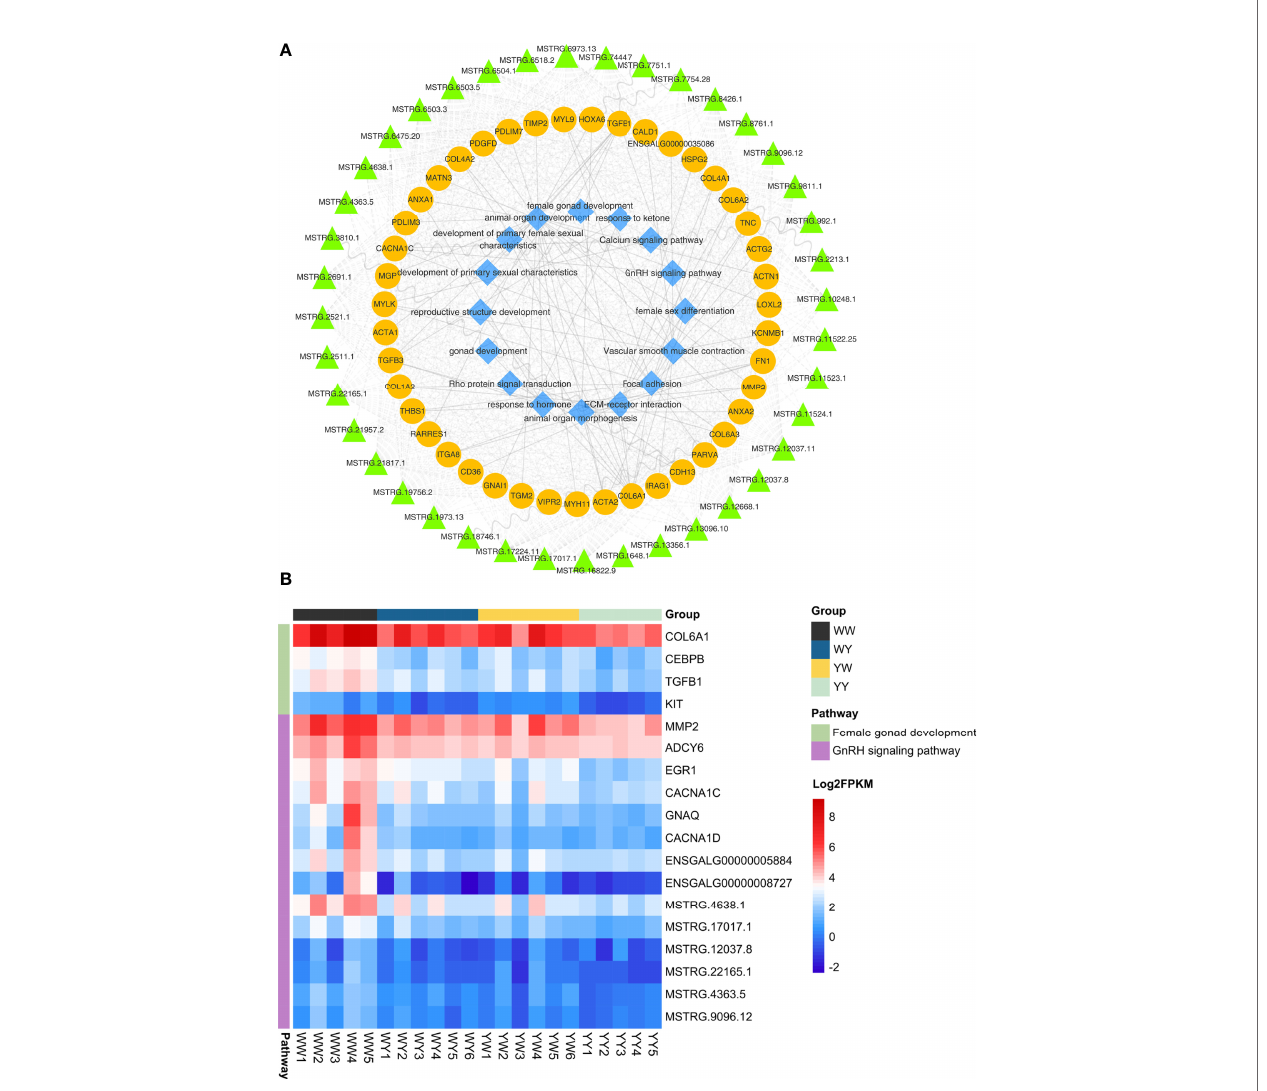
FIGURE 6 | Co-expression network analysis of the paired lncRNA-mRNA involved in sexual maturation. (A) Network of lncRNAs, mRNAs and function. The green triangle, yellow circles and blue diamond represent lncRNAs, mRNAs and function, respectively. (B) The expression of nonadditive mRNAs and their lncRNAs enriched in GnRH signaling pathway and female gonad